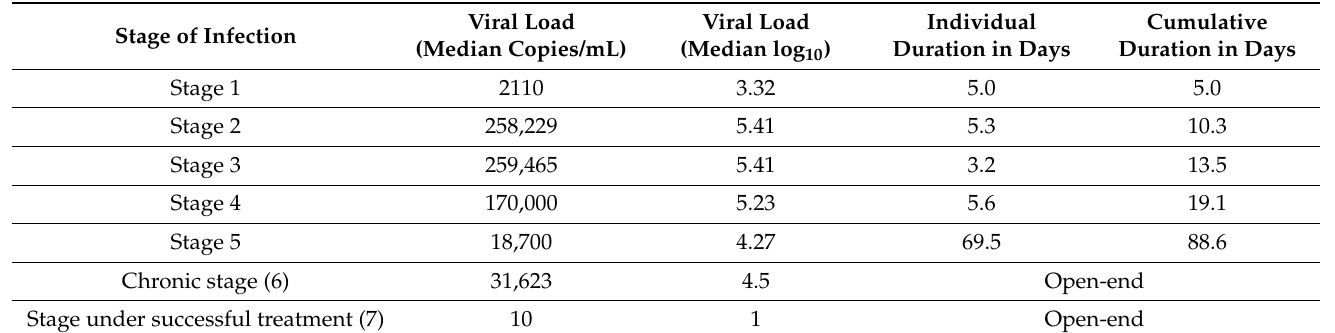
Table 3. Viral load by stage of infection according to [18–20] as summarized by our group in [8]. Stage of